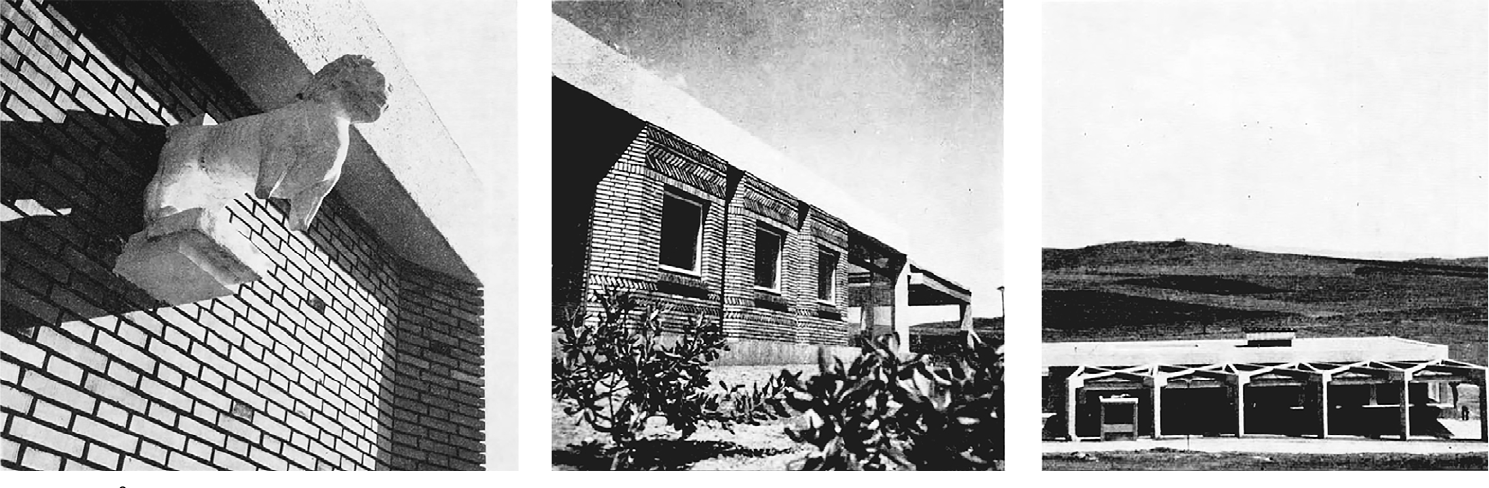
Gevgelija customhouse by Mi- hajlo Mitrović. (Source: Arhitek- tura Urbanizam, no.66(1970):